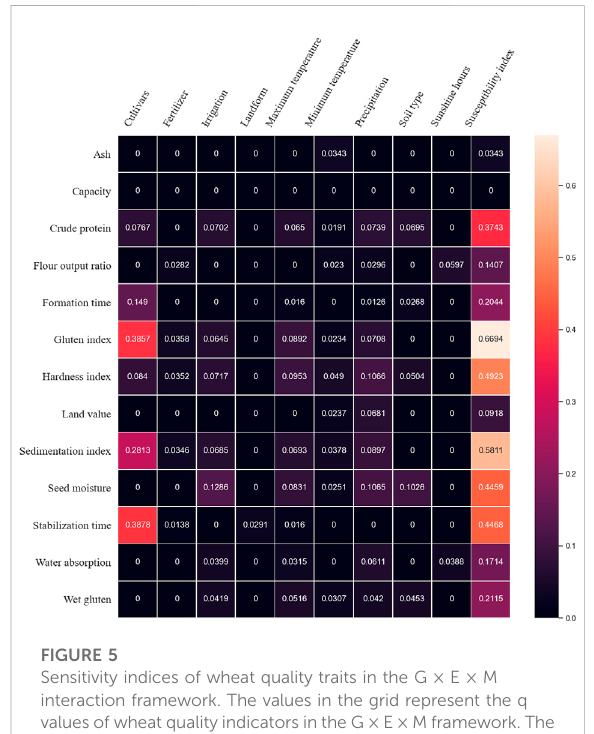
FIGURE 5 Sensitivity indices of wheat quality traits in the G × E × M interaction framework. The values in the grid represent the q values of wheat quality indicators in the G × E × M framework. The last value represents the sensitivity index of each wheat quality